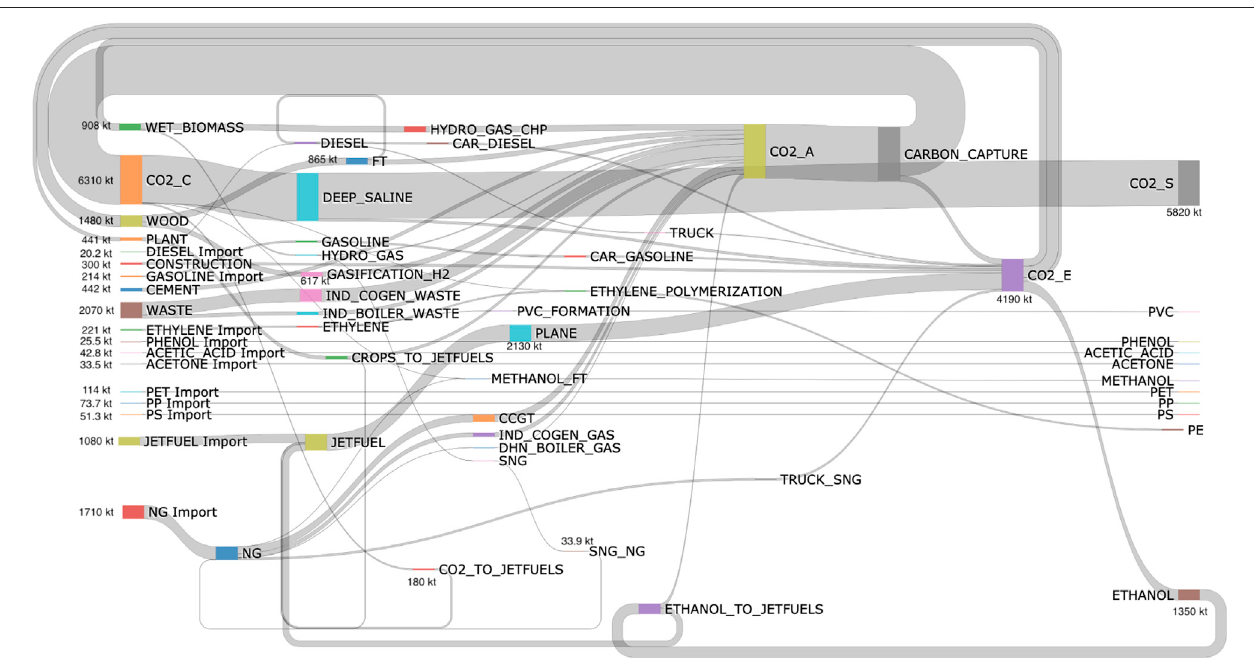
FIGURE 6 | Annual carbon fl ow (kt-C) in a net-zero-emission system with fossil fuel import.